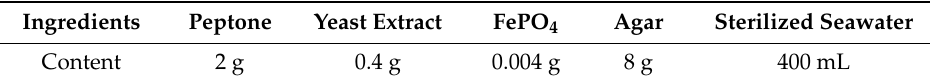
Table 1. Formula of 2216E solid